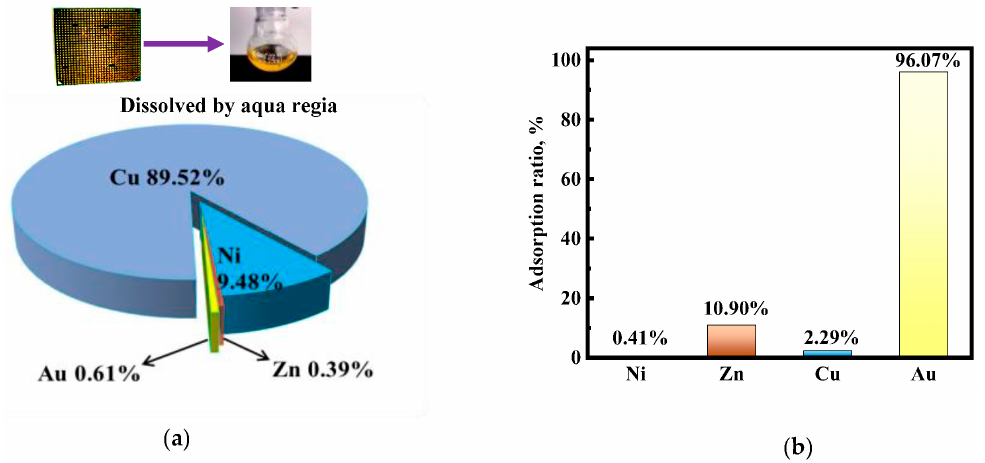
Figure 12. ( a ) Percentage of major metal elements; ( b ) adsorption rate of each metal ion.